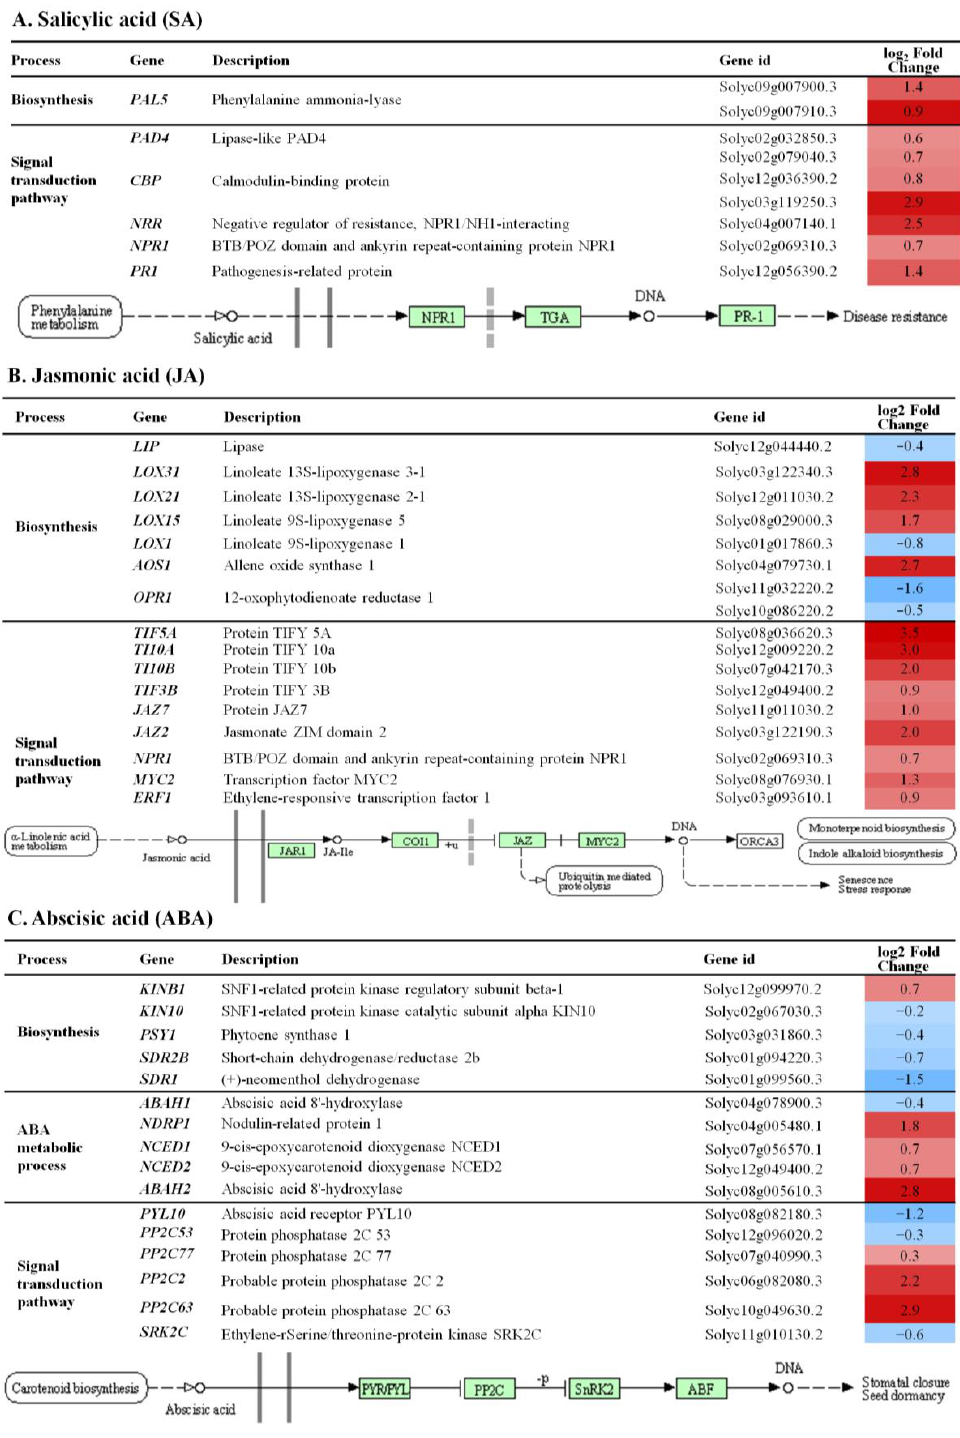
(circRNA) whitefly-induced gp91 was up-regulated (Supplementary Figure S2, Table 1), and CircRNAs were proved to act as miRNA sponges and inhibit miRNA activity.